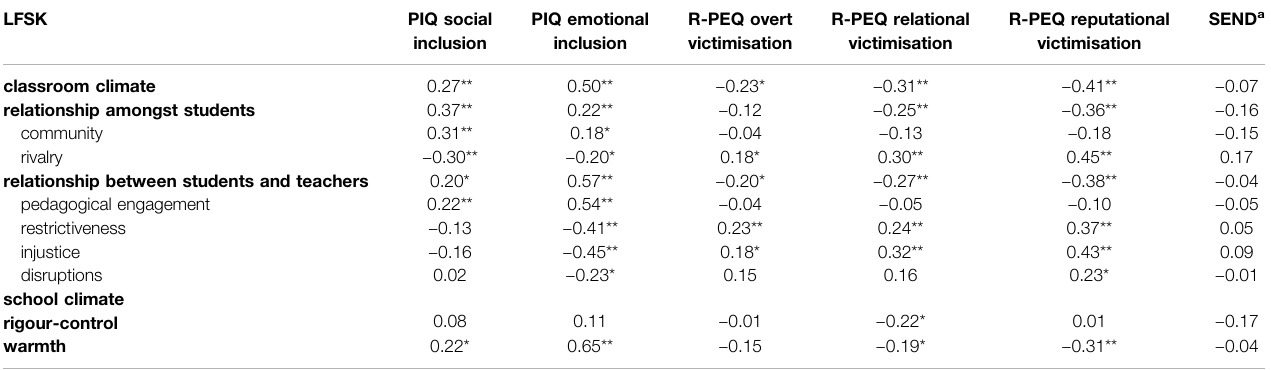
TABLE 3 | Spearman partial correlations between aspects of school and classroom climate and victimisation experiences, perceptions of inclusion and the presence of SEND.